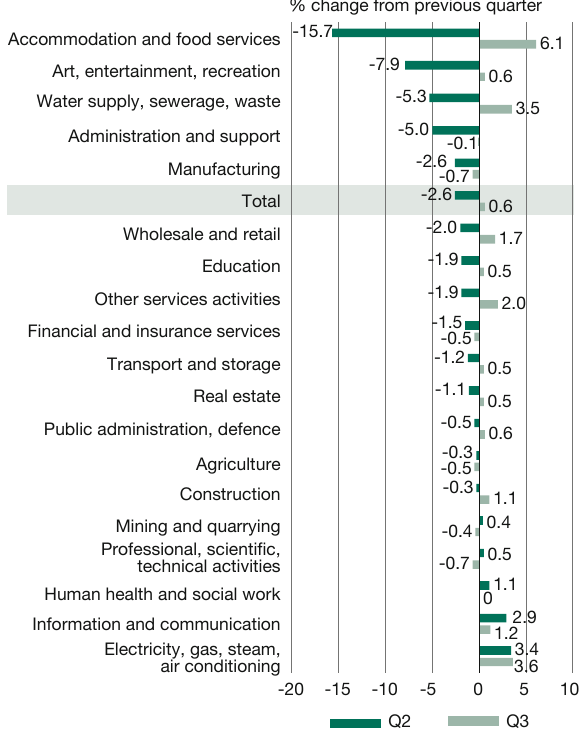
Quarter-on-quarter change in employment in